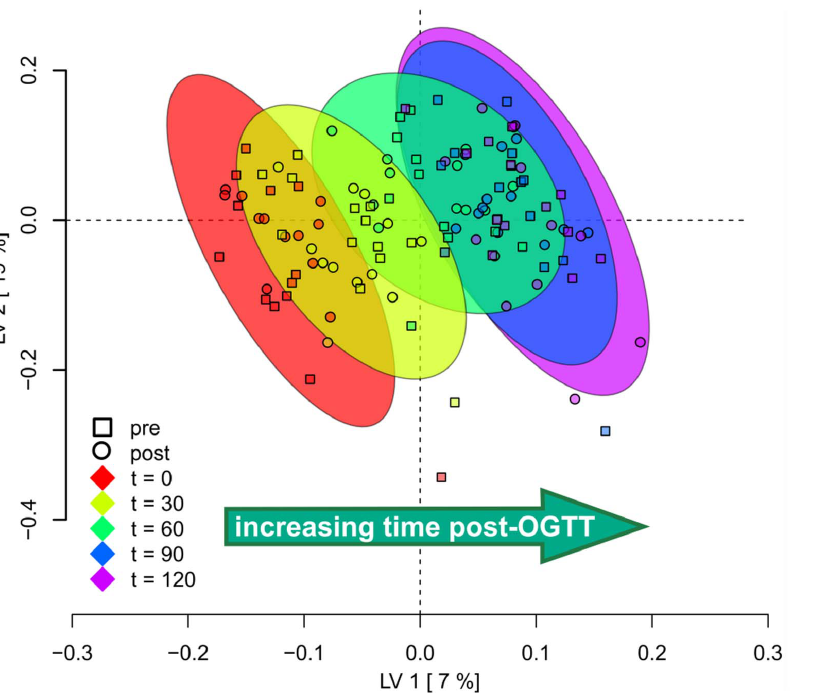
Figure 2. Subject Scores Plot derived from a partial least squares discriminate analysis (PLS-DA) model using temporal variance in identified plasma metabolites over the course of an OGTT in women. Each time point is represented by a different colored oval surrounding subject-time point groupings (see legend), and the score of each subject is represented as a symbol within time point cluster. Both pre- and post- intervention data were used to generate this plot (see Results). Note that variation in metabolite levels at each of the time points led to separation (discrimination) of clusters from one another, with the exception of the final 2 time points for which subject scores were similar.